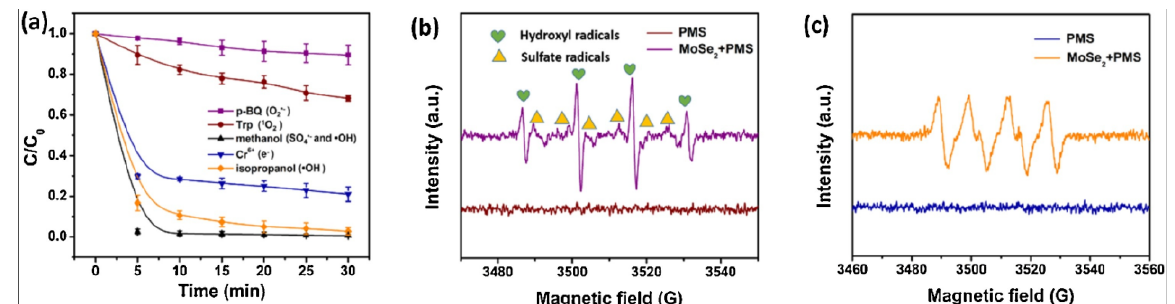
Figure 10. ( a ) Scavenger test for the degradation of CBZ; ( b ) EPR spectra for the detection of HO· and SO 4 · − in the presence of 5,5-dimethyl-1-pyrrolidineN-oxide (DMPO) at room temperature; ( c ) EPR spectra for the detection of O 2 · − in the presence of DMPO and methanol, (CH 3 OH) at room temperature. Reproduced with permission from [151].